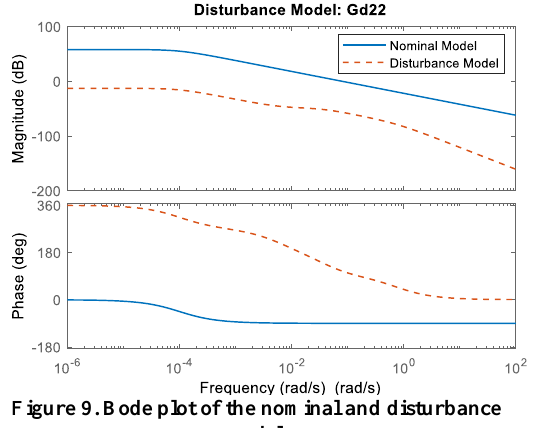
Figure 9. Bode plot of the nominal and disturbance model.